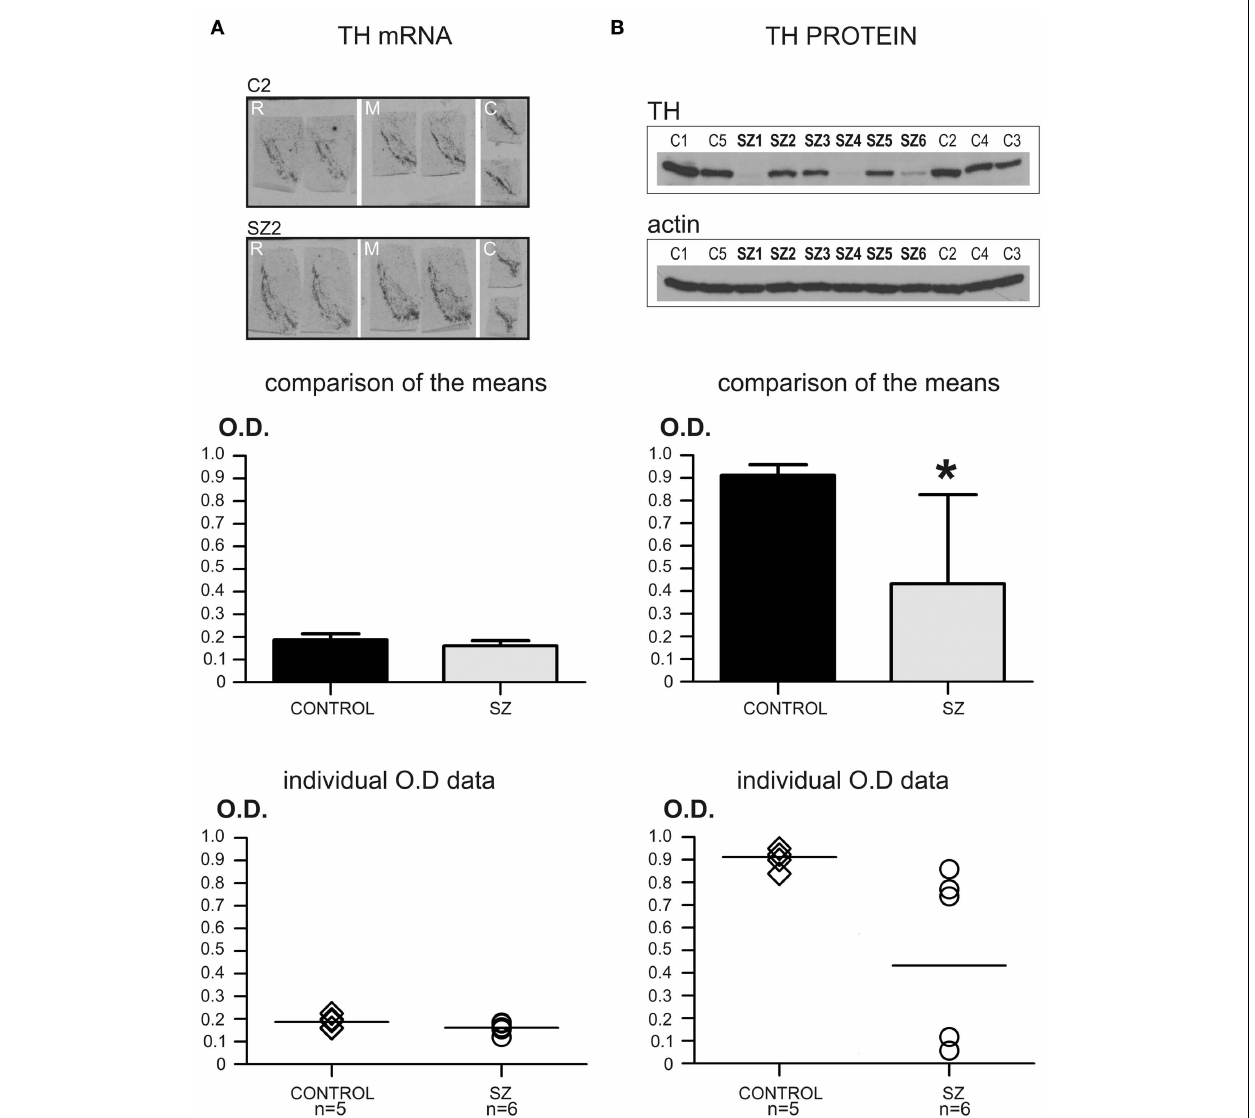
forTH protein, and then reblotted for actin.This membrane contained all the control (C1–C5) and schizophrenia (SZ1–SZ6) cases used in this pilot study. Note the conspicuous difference in blot signal among the different samples in theTH western-blot image, while actin expression is uniform among all cases.The comparison of the means forTH protein levels in controls and schizophrenia is shown in the mid panel (bar graph). OD values forTH protein were significantly different (*) between the two groups ( P = 0.031; OD mean ± SD: control = 0.912 ± 0.046, schizophrenia = 0.433 ± 0.393).The bottom panel shows a scatter plot for the individualTH protein OD values.The horizontal bar in the scatter plot indicates the mean OD value for each group. Note the dense clustering of the OD values for the control group, while in the schizophrenia group there is a large scattering of the data. However, note that in the lowerTH expression cluster, two cases presented the same exactTH OD value and are represented in the scatter plot as a single